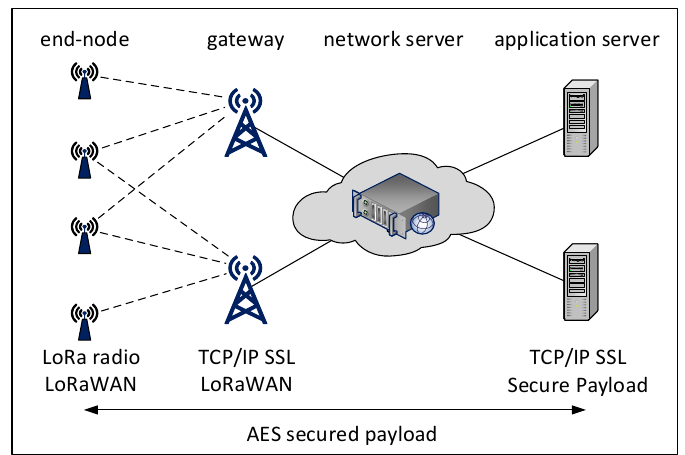
Figure 1. General long-range wide-area-network (LoRaWAN) architecture with end-to-end security using advanced encryption standard (AES) and secure sockets layer (SSL) for TCP/IP